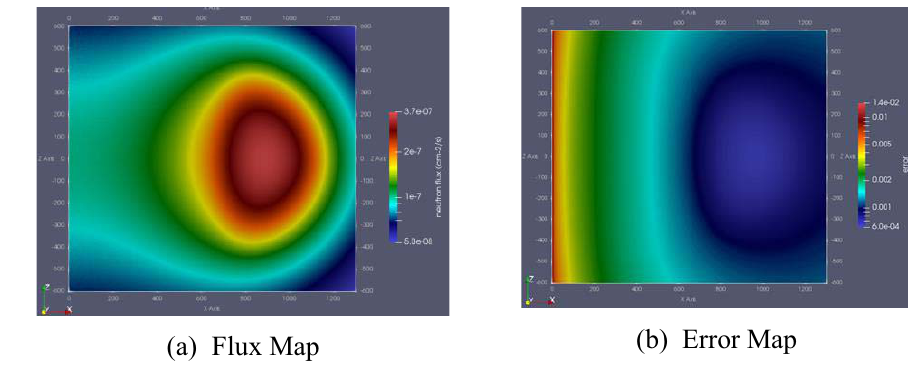
Figure 1. Neutronic Model of European HCPB DEMO in SuperMC